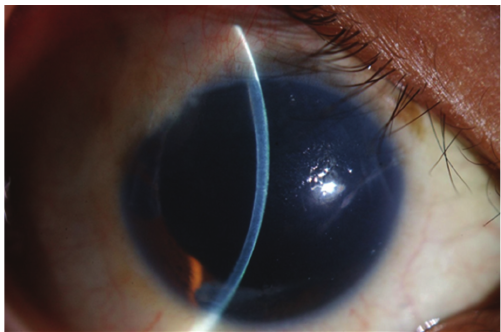
Figure 1: Clinical picture on presentation showing corneal edema, peripheral corneal scarring, aniridia with only a sector of iris tissue remaining temporally, and aphakia.